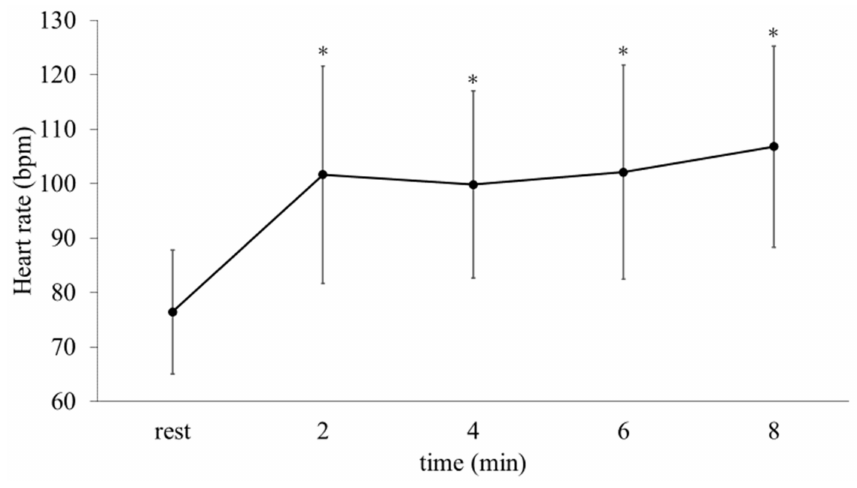
Figure 5. Changes in HR during the games ( n = 25). *: p < 0.001 vs. rest. Note that the number of data points at 8 min was 16 because 9 participants had finished their games before 8 min. Table 2. Changes of blood pressure ( n = 25). Pre Post p